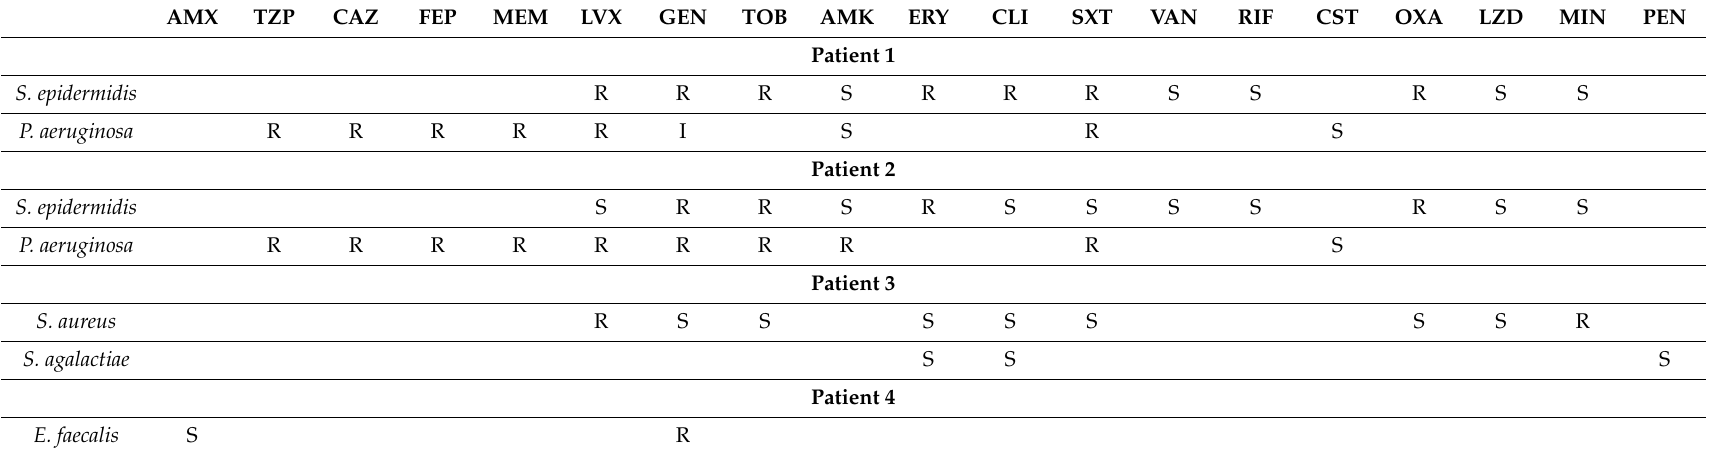
Table 2. Isolated pathogens and associated antibiotic susceptibility